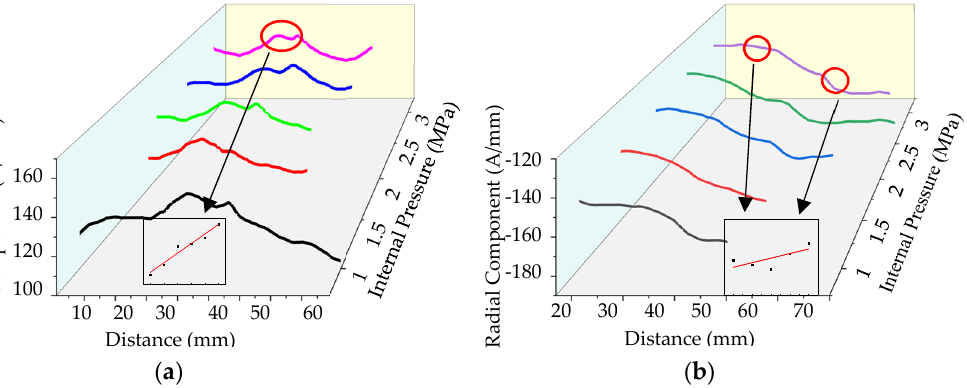
Figure 15. The weak magnetic signal of pipeline crack with different internal pressures: ( a ) axial component and ( b ) radial component. And the axial maximum and the radial peak of the weak magnetic signal at the crack are extracted, the relationship between the signal and the internal pressure is shown in the figure.